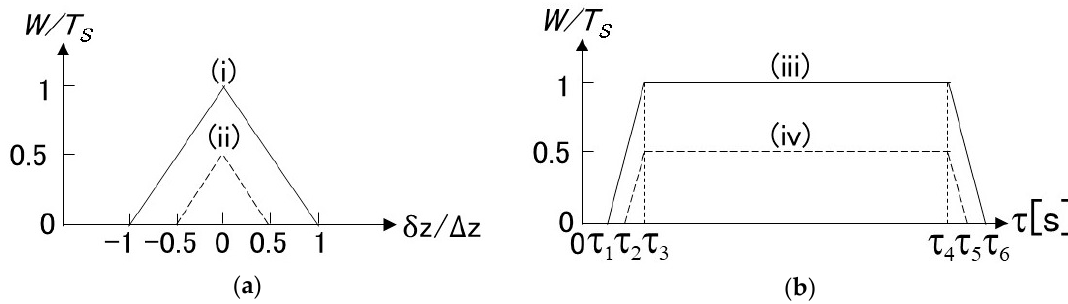
Figure 3. Function W ( τ , z ) : ( a ) z-dependency, (i) τ 3 ≤ τ ≤ τ 4 [s], (ii) τ = τ 2 , τ = τ 5 [s]; ( b ) Figure 3. Function 𝑊(cid:4666)𝜏,𝑧(cid:4667) : ( a ) z-dependency, (i) τ (cid:2871) ≤ τ ≤ τ (cid:2872) [s], (ii) τ = τ (cid:2870) , τ = τ (cid:2873) [s]; ( b ) 𝜏 – dependency, (iii) 𝛿𝑧 = 0 [m], (iv) |𝛿𝑧| = ∆𝑧 2⁄ [m]; τ (cid:2869) = 𝑇 (cid:3010) [s], τ (cid:2870) = 𝑇 (cid:3010) + (cid:4666)𝑇 (cid:3020) 2⁄ (cid:4667) [s], τ (cid:2871) = 𝑇 (cid:3010) + 𝑇 (cid:3020) [s], τ (cid:2872) = 𝑇 (cid:3010) + 𝑇 (cid:3013) [s], τ (cid:2873) = 𝑇 (cid:3010) + 𝑇 (cid:3013) + (cid:4666)𝑇 (cid:3020) 2⁄ (cid:4667) [s], τ (cid:2874) = 𝑇 (cid:3010) + 𝑇 (cid:3013) + 𝑇 (cid:3020) [s].